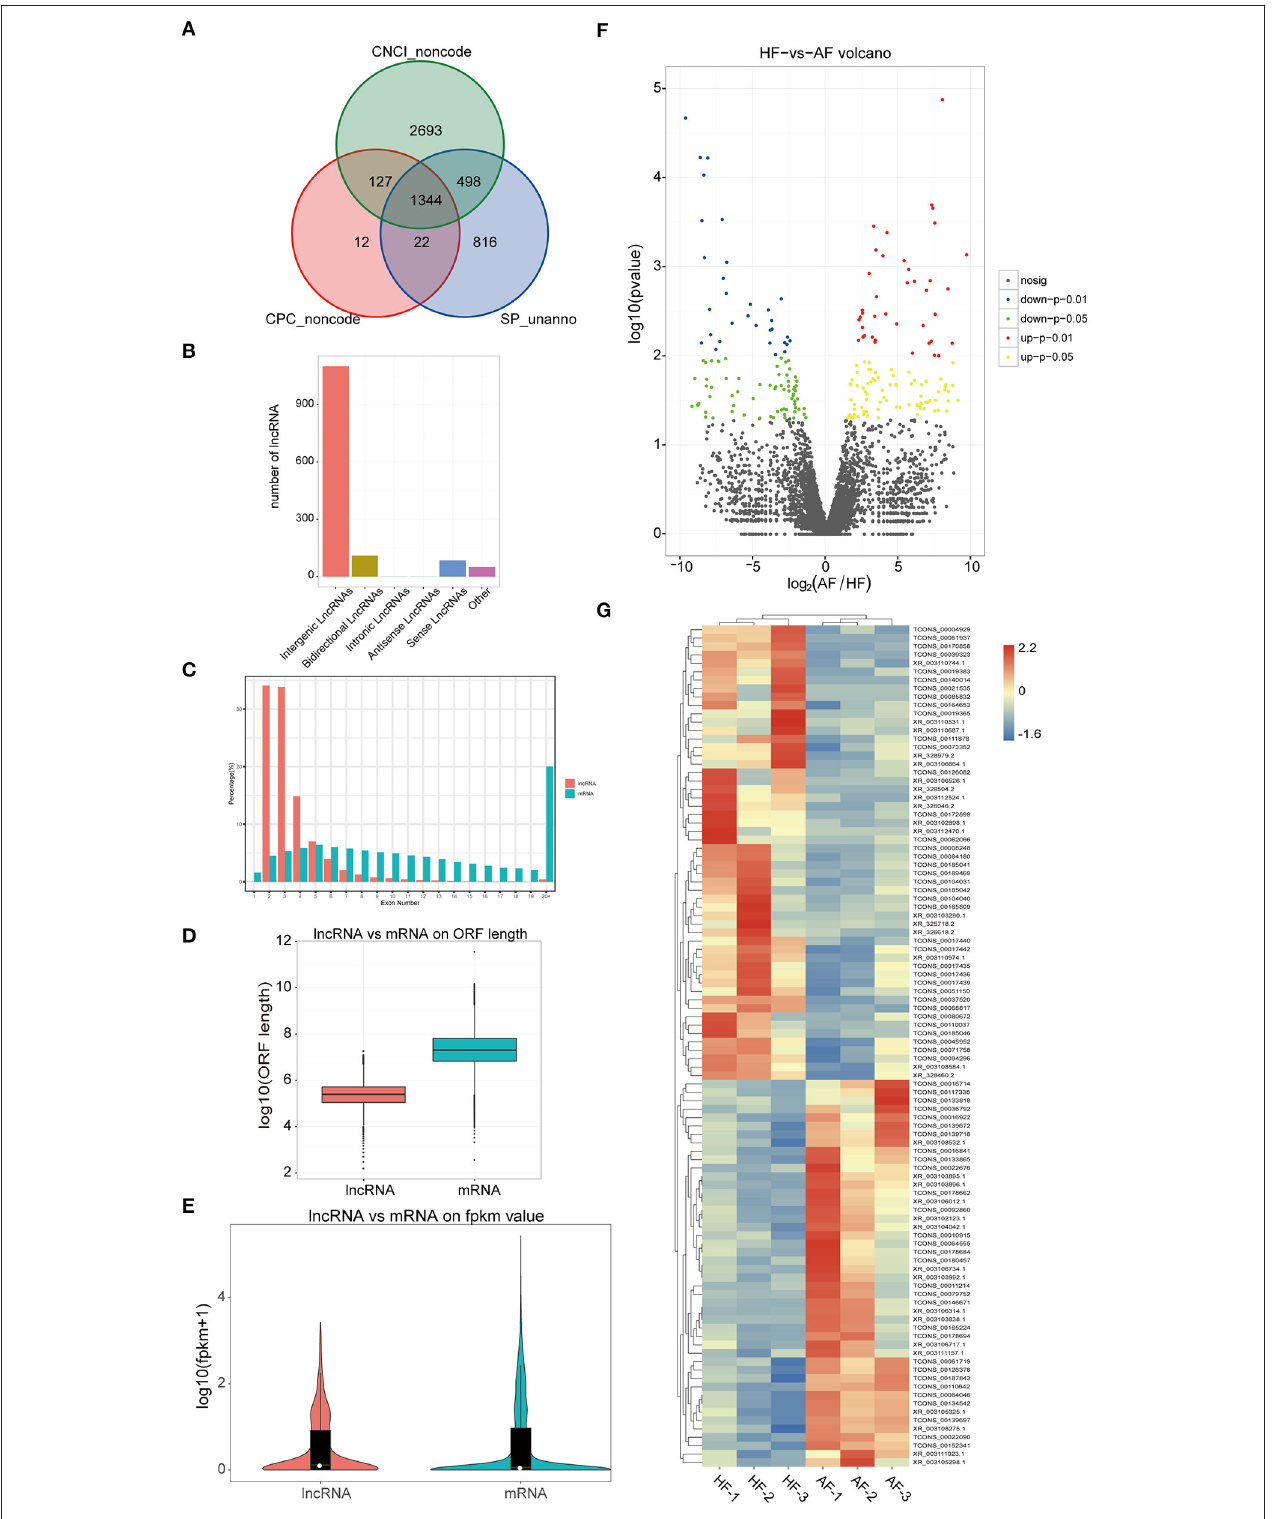
FIGURE 4 | Identification and analysis of DElncRNAs in granulosa cells between healthy and atretic follicles. (A) Venn diagram of the lncRNA annotation results of CPC, CNCI, and SwissProt. (B) LncRNA classification histogram. (C–E) Comparison of lncRNA with mRNA with respect to the transcript length, exon number, ORF length, and FPKM values. (F) Volcano plot of the expression of DElncRNAs in different groups. (G) Heat map of all DElncRNAs.